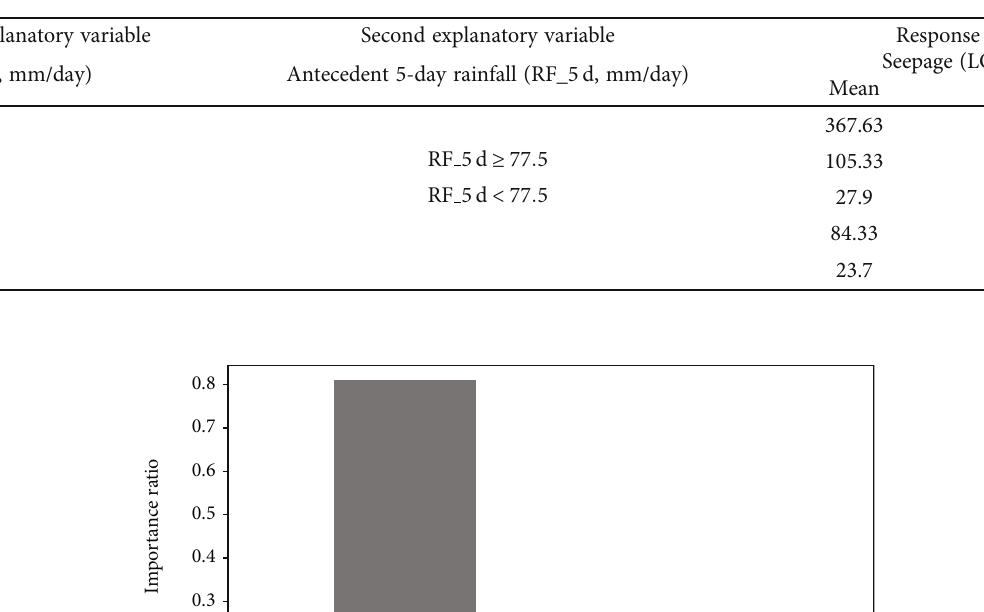
Table 5: Results of decision tress analysis for group B.